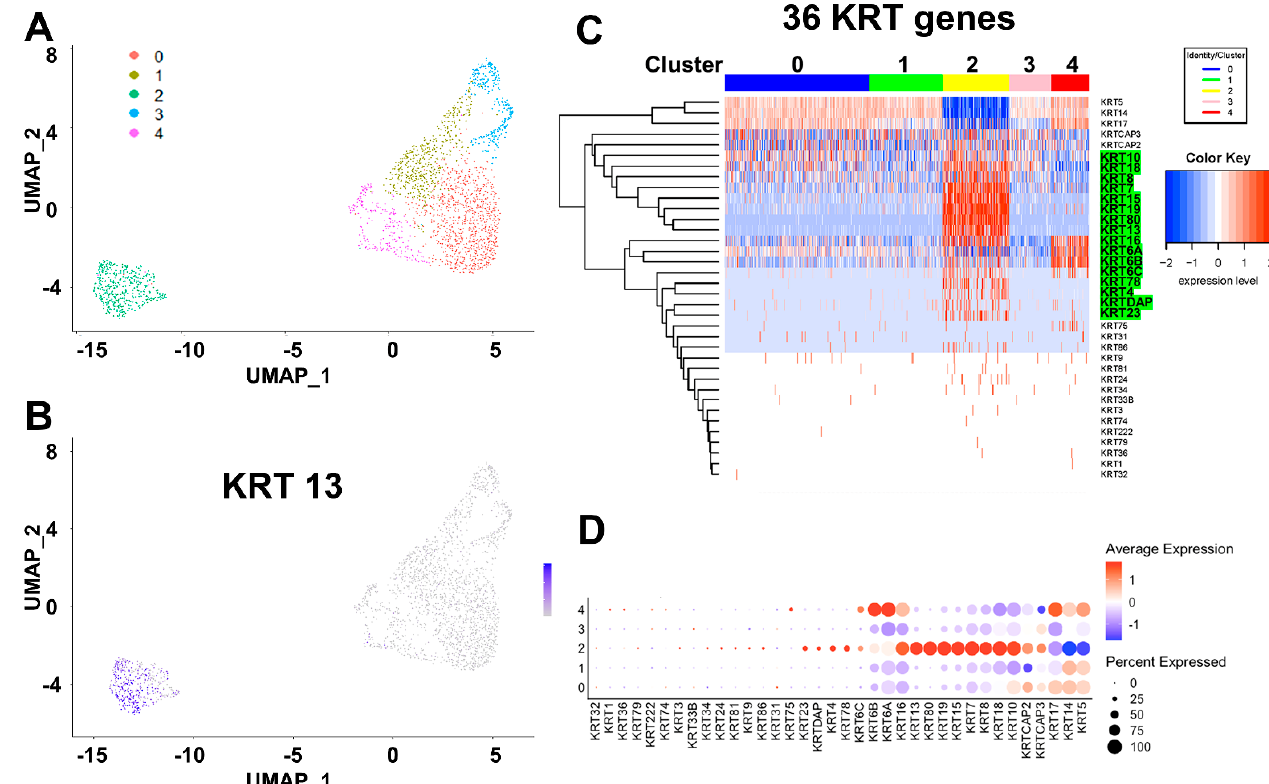
Figure 7. Keratin profiling in tumor spheroids using single-cell RNA-seq identifies cancer stem-like cells. ( A , B ) Uniform manifold approximation and projection (UMAP) clustering defined five clusters in cancer cells, identifying cluster 2 as cancer stem-like cells enriched for stemness markers, including KRT13 . ( C ) Keratin gene profiling by heatmap and ( D ) dot-plot analyses identified a group of keratin genes enriched in the cluster 2 cancer stem-like cells.